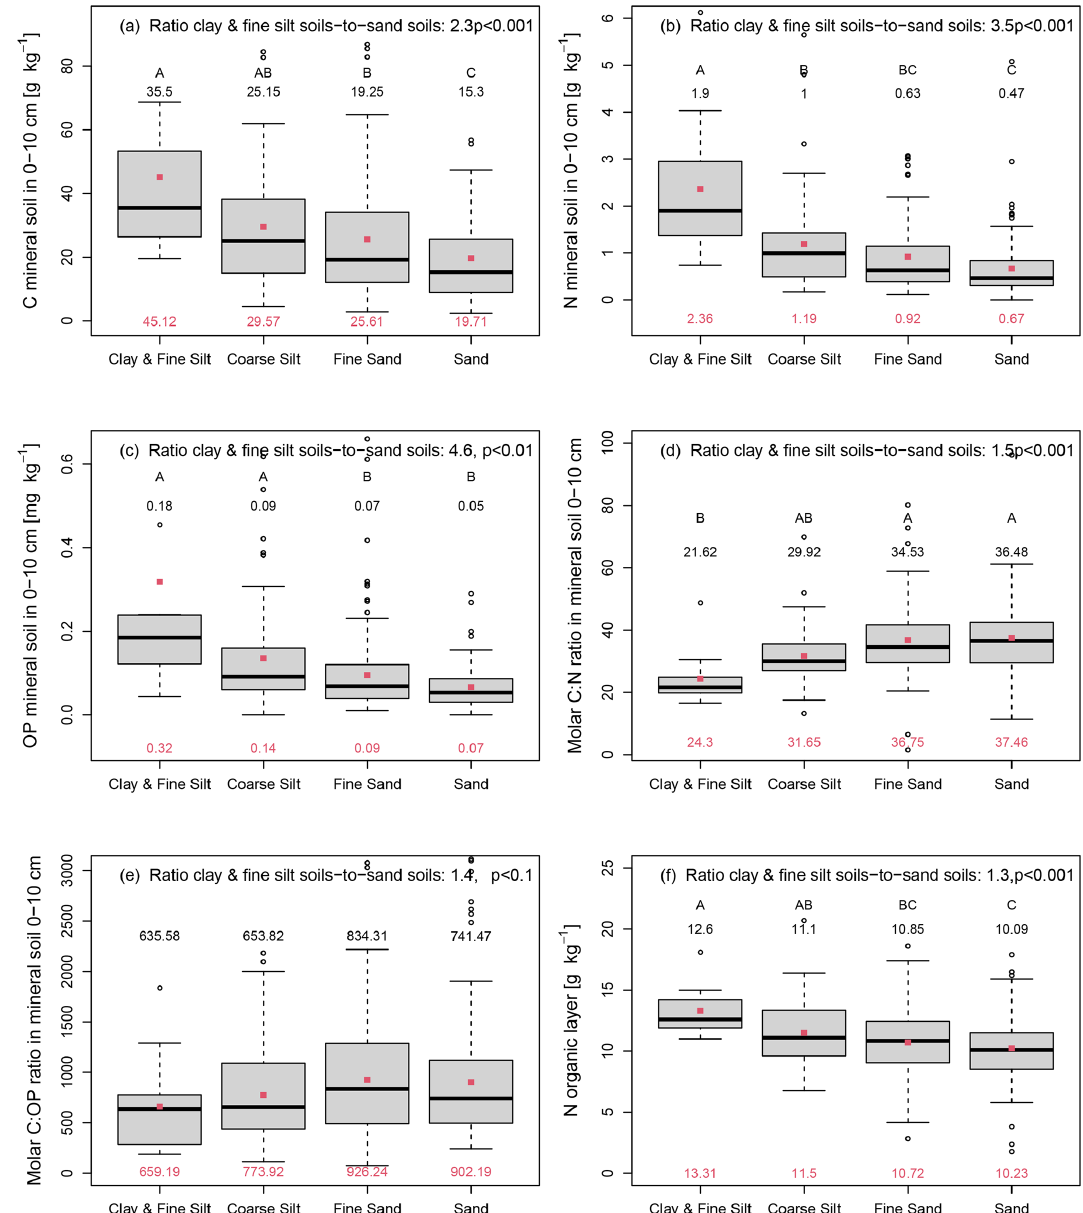
Figure 4. Carbon (a) , nitrogen (b) , and organic phosphorus (c) concentrations, the molar carbon-to-nitrogen (C : N) ratio (d) , and the molar carbon-to-organic phosphorus (C : OP) ratio (e) in the mineral soil at a depth of 0–10cm, as well as the nitrogen (N) concentration of the organic layer (f) depending on the soil texture (clay and fine silt n = 11, coarse silt n = 52, fine sand n = 136, and sand n = 110) in 309 Swedish forest soils with a stand age > 60 years. The texture class called sand encompasses sand and coarse sand. The indicated ratio of clay and fine silt soil-to-sand soils is the mean ratio. Black numbers give the median, and red dots and red numbers depict the arithmetic mean. Different capital letters indicate statistically significant differences ( p < 0 . 05) between the soils of different texture classes, while the p value of the ANOVA is indicated in the right corner of each